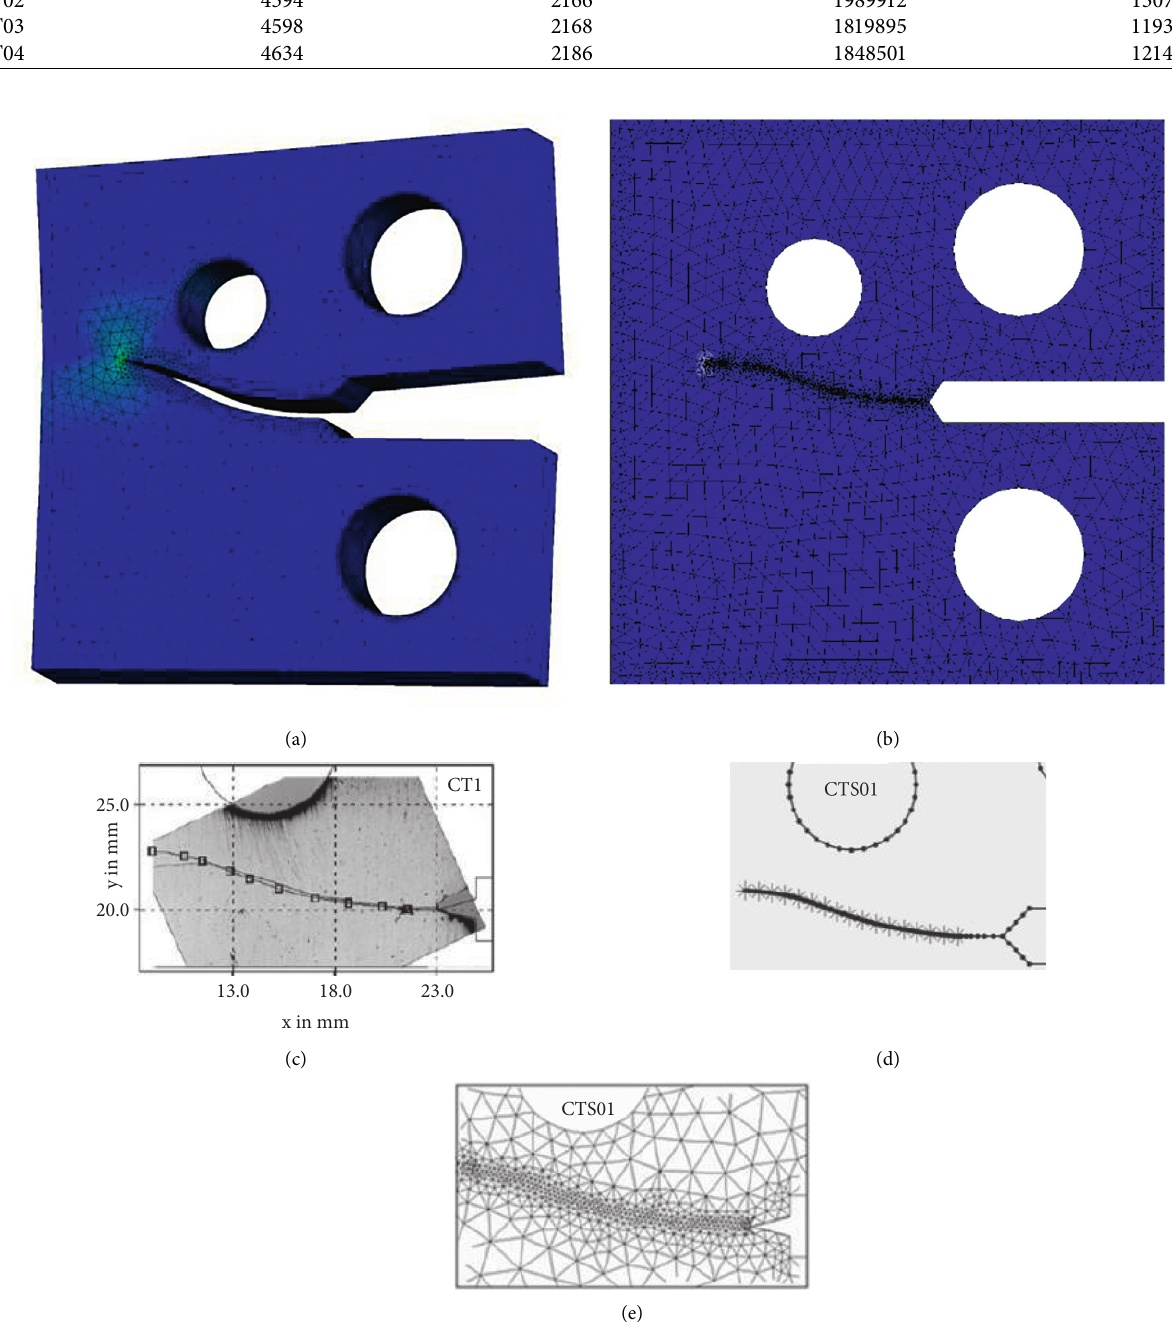
Figure 5: The predicted crack path of CTS01. (a) ANSYS results, (b) FRANC2D/L, (c) experimental and numerical outcome of [50], (d) BemCracker2D software [32], and (e) Quebra2D software [32].